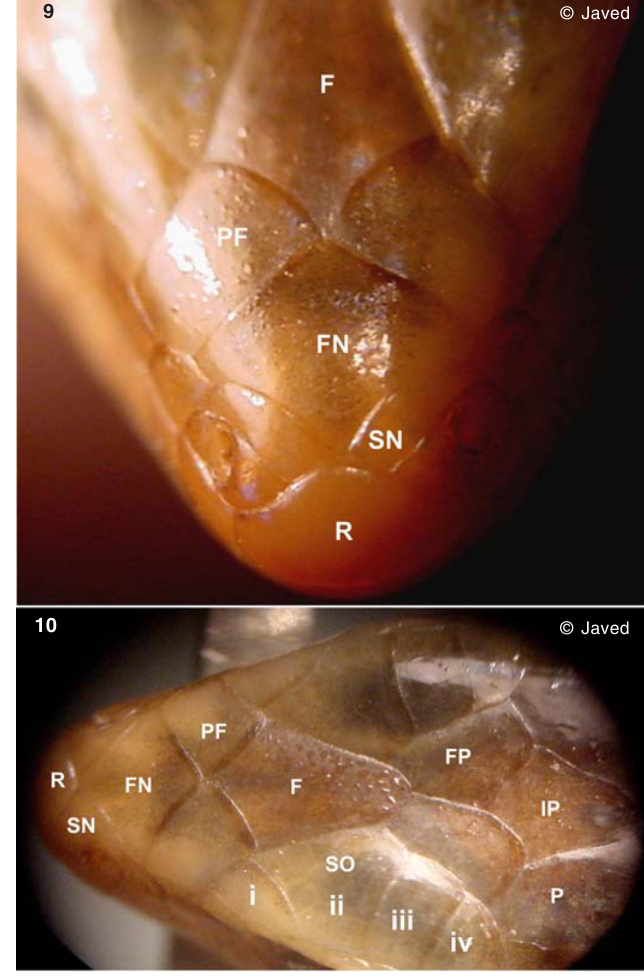
Images 9-10. Eutropis innotata . 9 - Dorsal aspect of snout showing rostral (R), supranasals (SN), fronto-nasal (FN), prefrontal (PF) and frontal (F); 10 - Dorsal aspect of head showing rostral (R), supranasals (SN), fronto- nasal (FN), prefrontals (PF), frontal (F), 4 supraoculars (SO), fronto-parietals (FP), interparietal (IP) and parietals